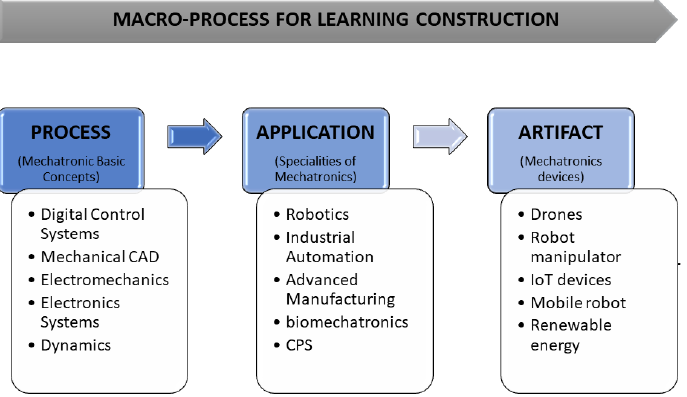
Figure 1. The mechatronics educational framework and